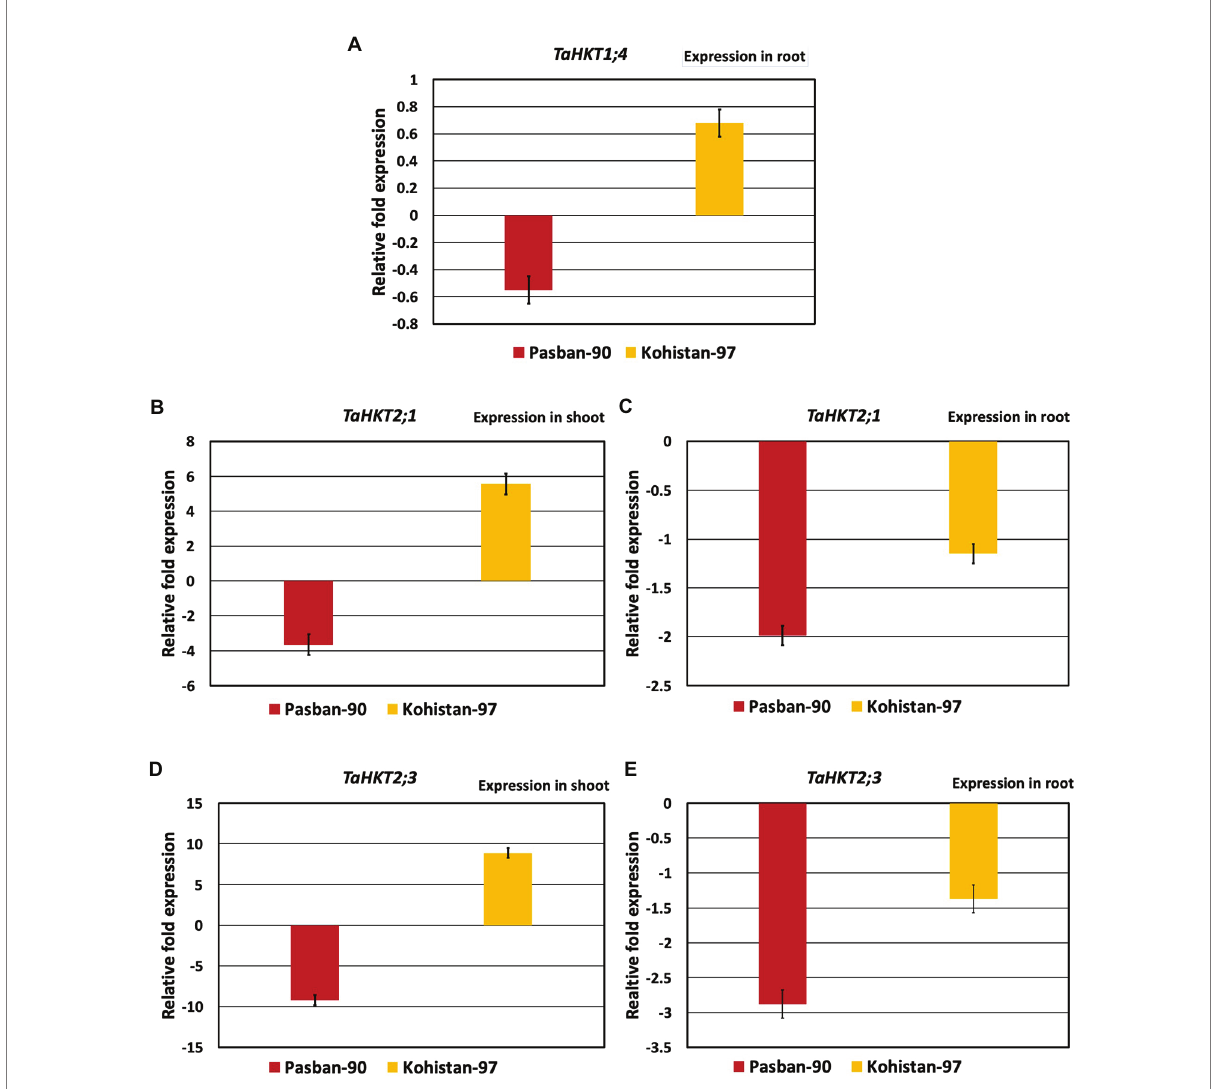
FIGURE 6 High affinity potassium transporter (HKT) salt responsive genes expression analysis (RT-qPCR). (A) Accumulation of transcript of TaHKT1;4 in root, (B) expression analysis of TAHKT2;1 in shoot, (C) expression analysis of TaHKT2;1 in root, (D) expression analysis of TaHKT2;3 in shoot, (E) expression analysis of TYaHKT2;3 in root. The results are mean fold change in relative expression over the control with three biological and three technical replicates, normalized with actin (reference) gene expression. Bars represent standard deviation.